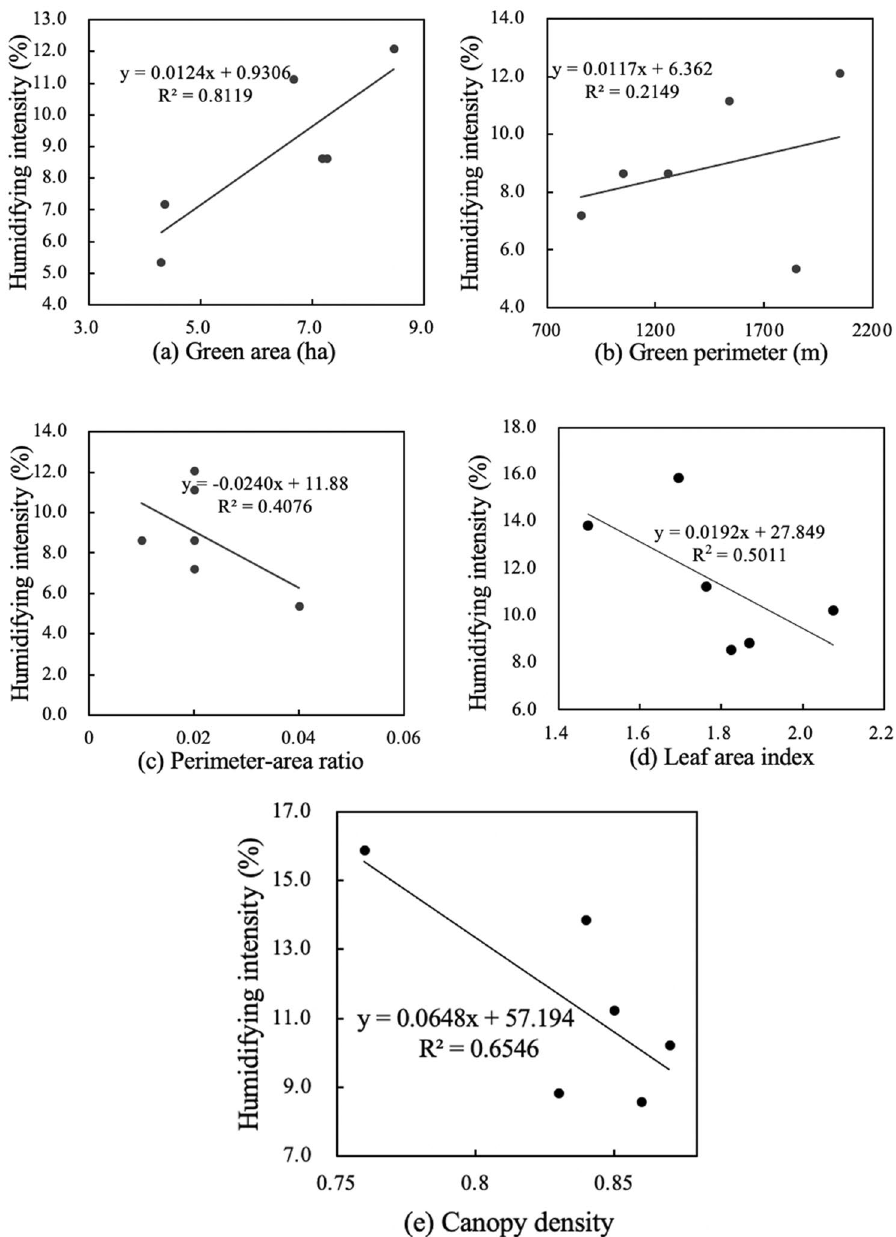
Figure 8. Linear regressions of spatial characteristics and humidifying intensity of medium-size green